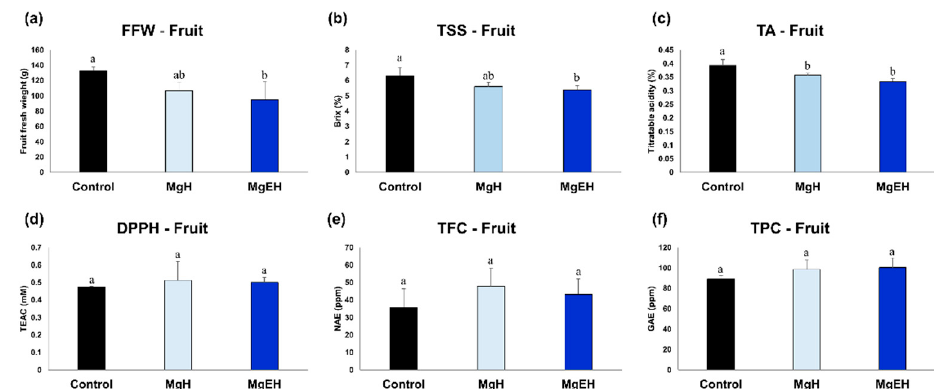
Figure 1. Effect of Mg oversupply on the fruit fresh weight ( a ), total soluble solid ( b ), and titratable acidity ( c ). Results of bioactivities [1,1-diphenyl-2-picrylhydrazyl (DPPH) ( d ), total flavonoids